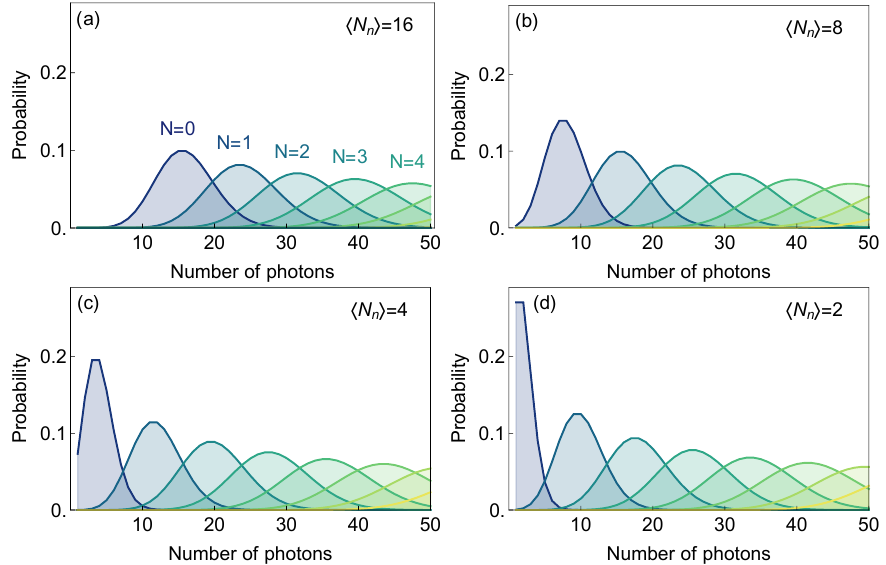
Figure 3. ( a – d ) Probabilities L ( N ph | N ) to detect a different number of photons in a single trial (consisting of approximately 2400 excitation pulses at 80 MHz repetition rate) of the ensemble with given number of emitters N for the average signal intensity (cid:104) N b (cid:105) = 8 and set of different noise levels (cid:104) N n (cid:105) = { 16,8,4,2 } (SNR = { 0.5,1,2,4 }